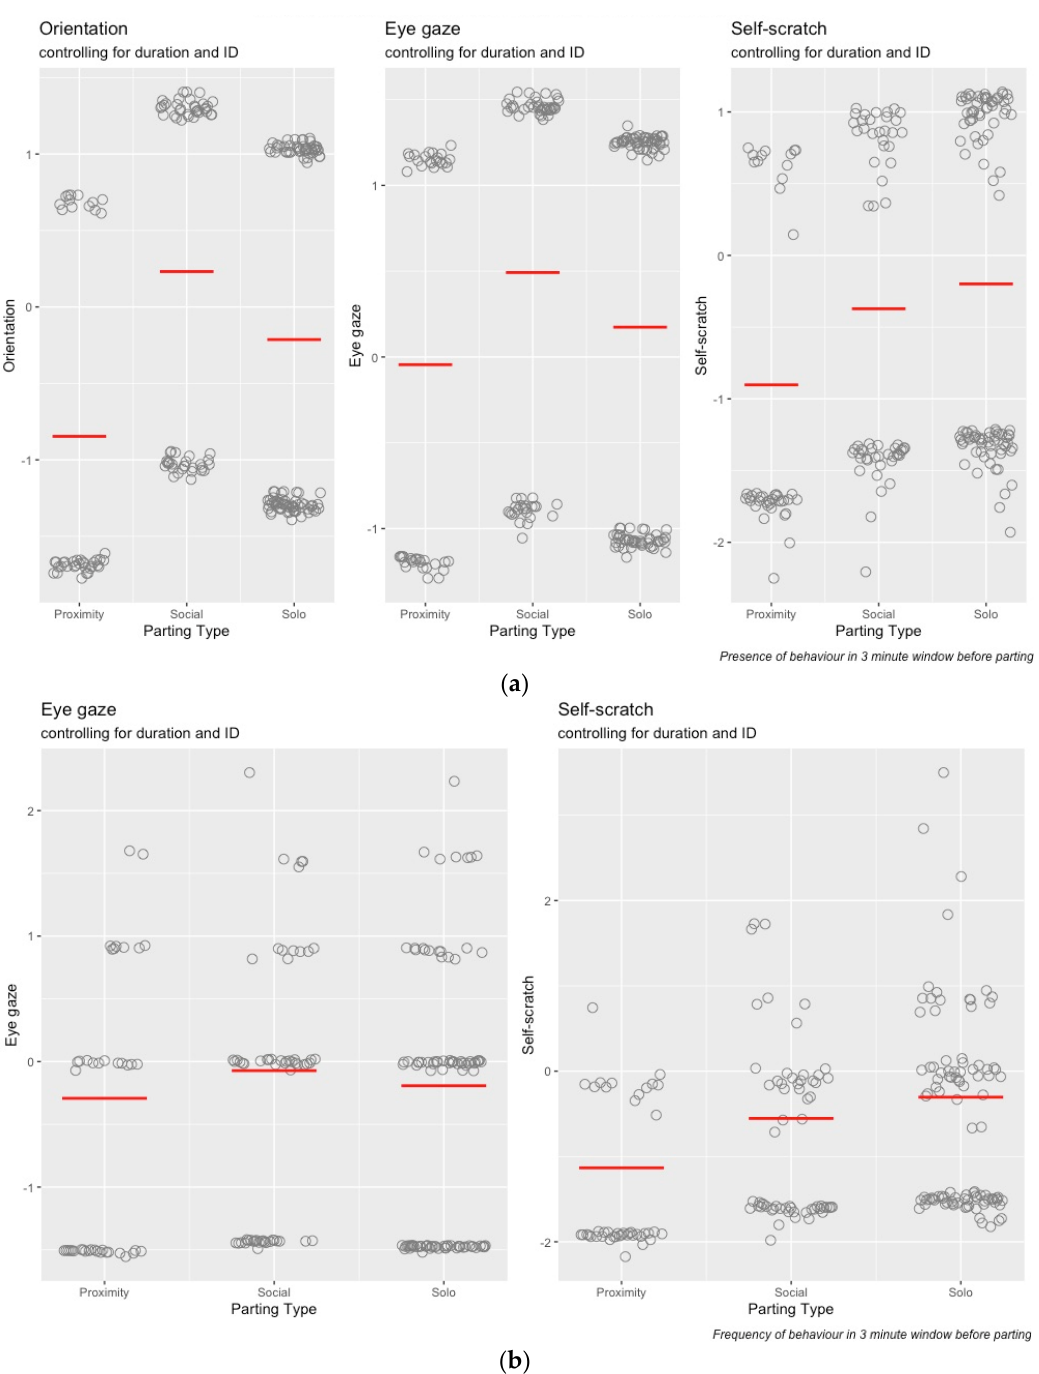
Figure 5. ( a , b ) Relationship between candidate behaviour presence and parting